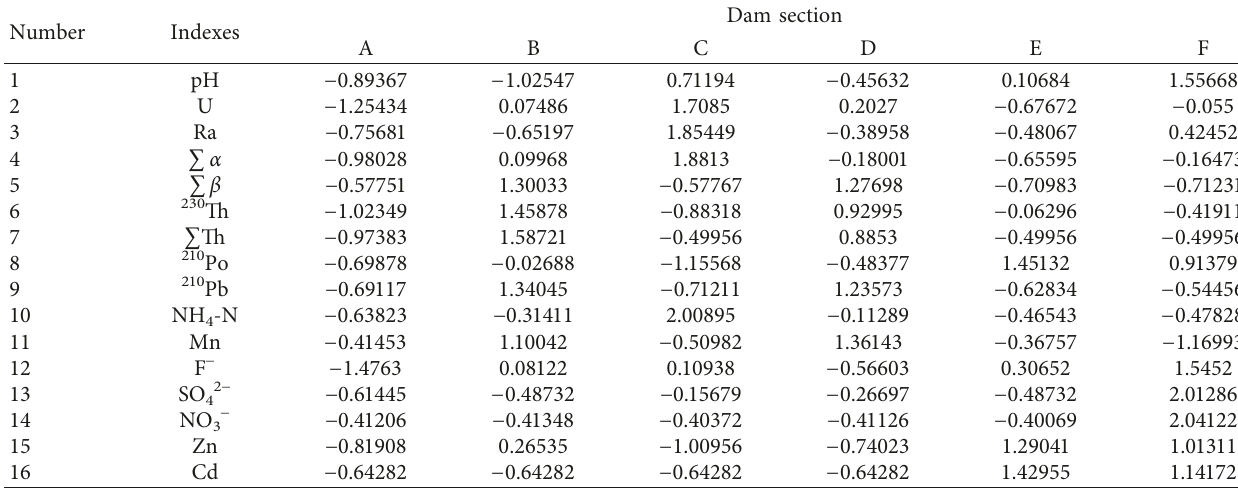
Table 1: Standardized data of the seepage